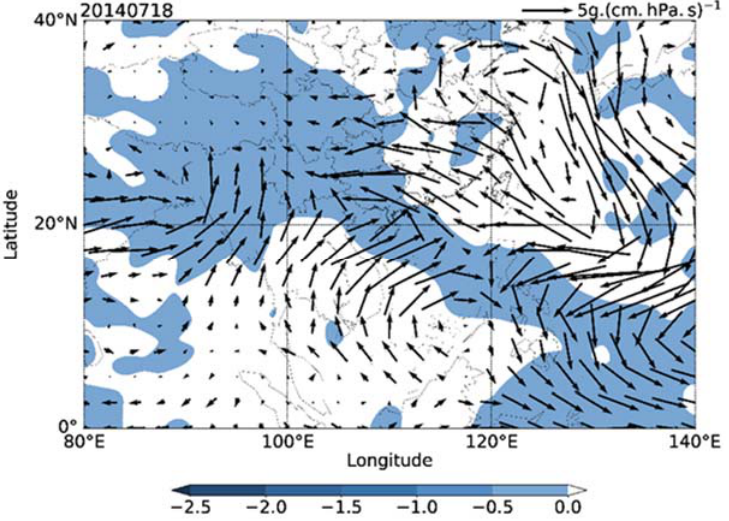
Figure 11. The 850 hPa low ‐ frequency water vapor flux without TC (vector; units: units: g ∙ s (cid:2879)(cid:2869) ∙ hPa (cid:2879)(cid:2869) ∙ cm (cid:2879)(cid:2869) ) and its divergence on July 18 (shading denotes the flux convergence; units: 10 (cid:2879)(cid:2875) g ∙ s (cid:2879)(cid:2869) ∙ hPa (cid:2879)(cid:2869) ∙ cm (cid:2879)(cid:2870) ).